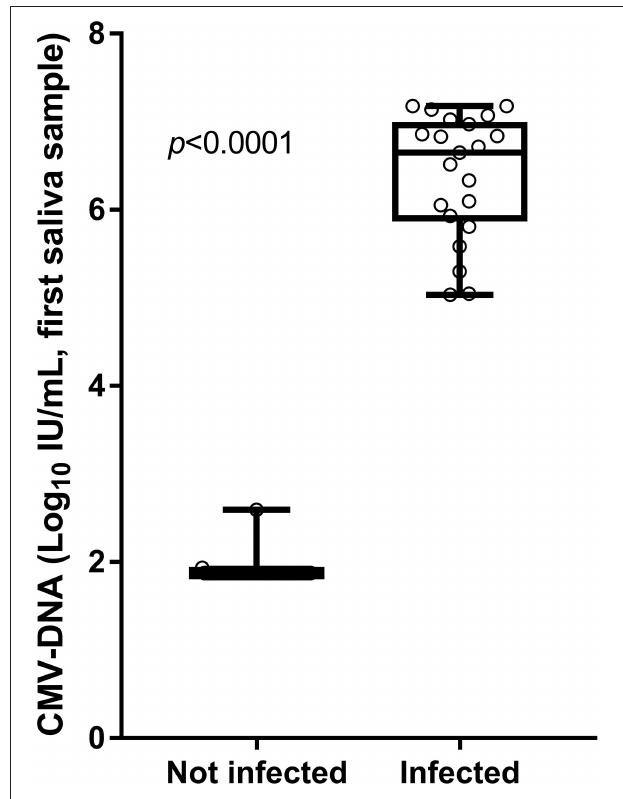
FIGURE 4 | Viral loads detected in screening saliva samples from infants with and without cCMV infection.